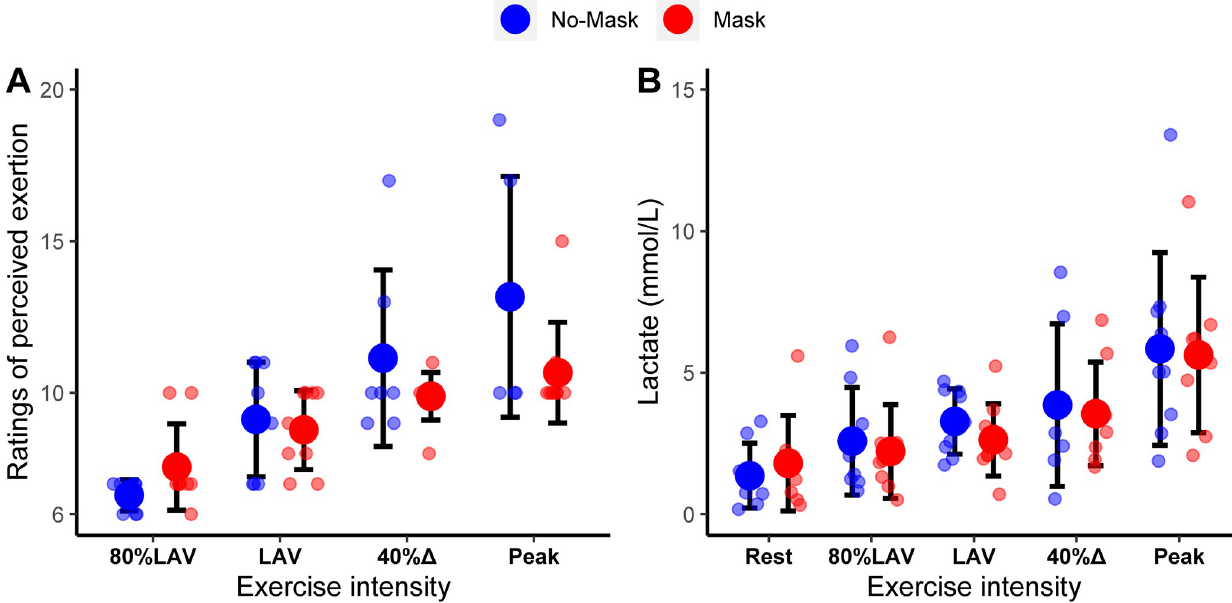
Fig 3. Ratings of perceived exertion (A) and blood lactate concentration (B) during a progressive square-wave test with or without wearing a facemask. Data expressed as means and standard deviations and individual data.